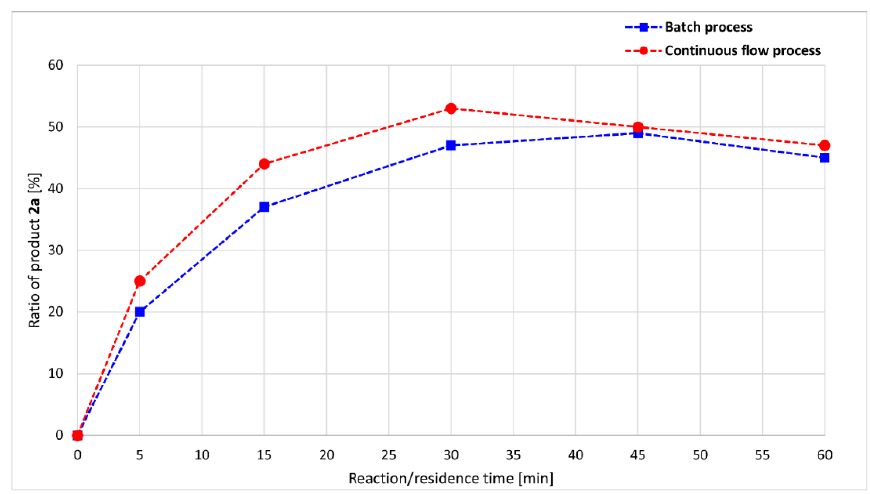
Figure 5. Reaction/residence time-dependence of the product 2a ratio in the alcoholysis of DMP with n BuOH at 100 °C.